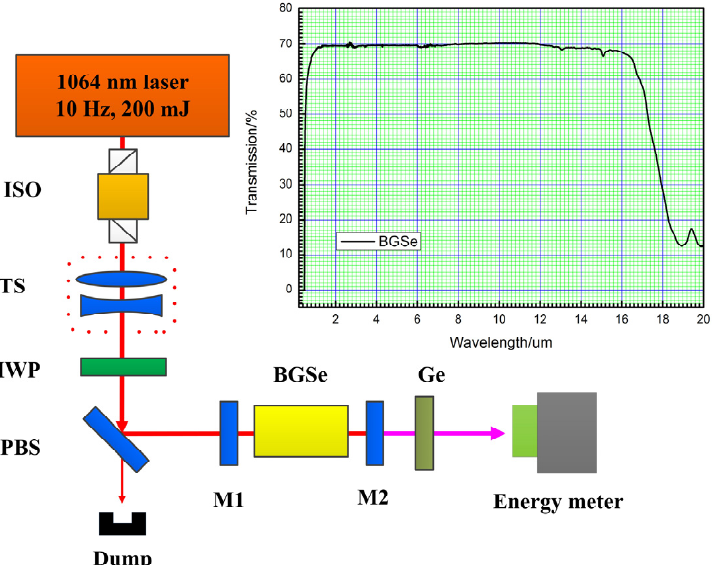
Figure 2. Schematic of the experimental setup. ISO: optical isolator; TS: telescope system; HWP: half-wave-plate at 1.064 μ m; PBS: 45° polarized beam splitter at 1.064 μ m; M1: input coupler (plane mirror); M2: output coupler (plane mirror); Ge: germanium filter mirror. Inset: transmission spectrum of uncoated BGSe sample in 0.2~20 μ m range.